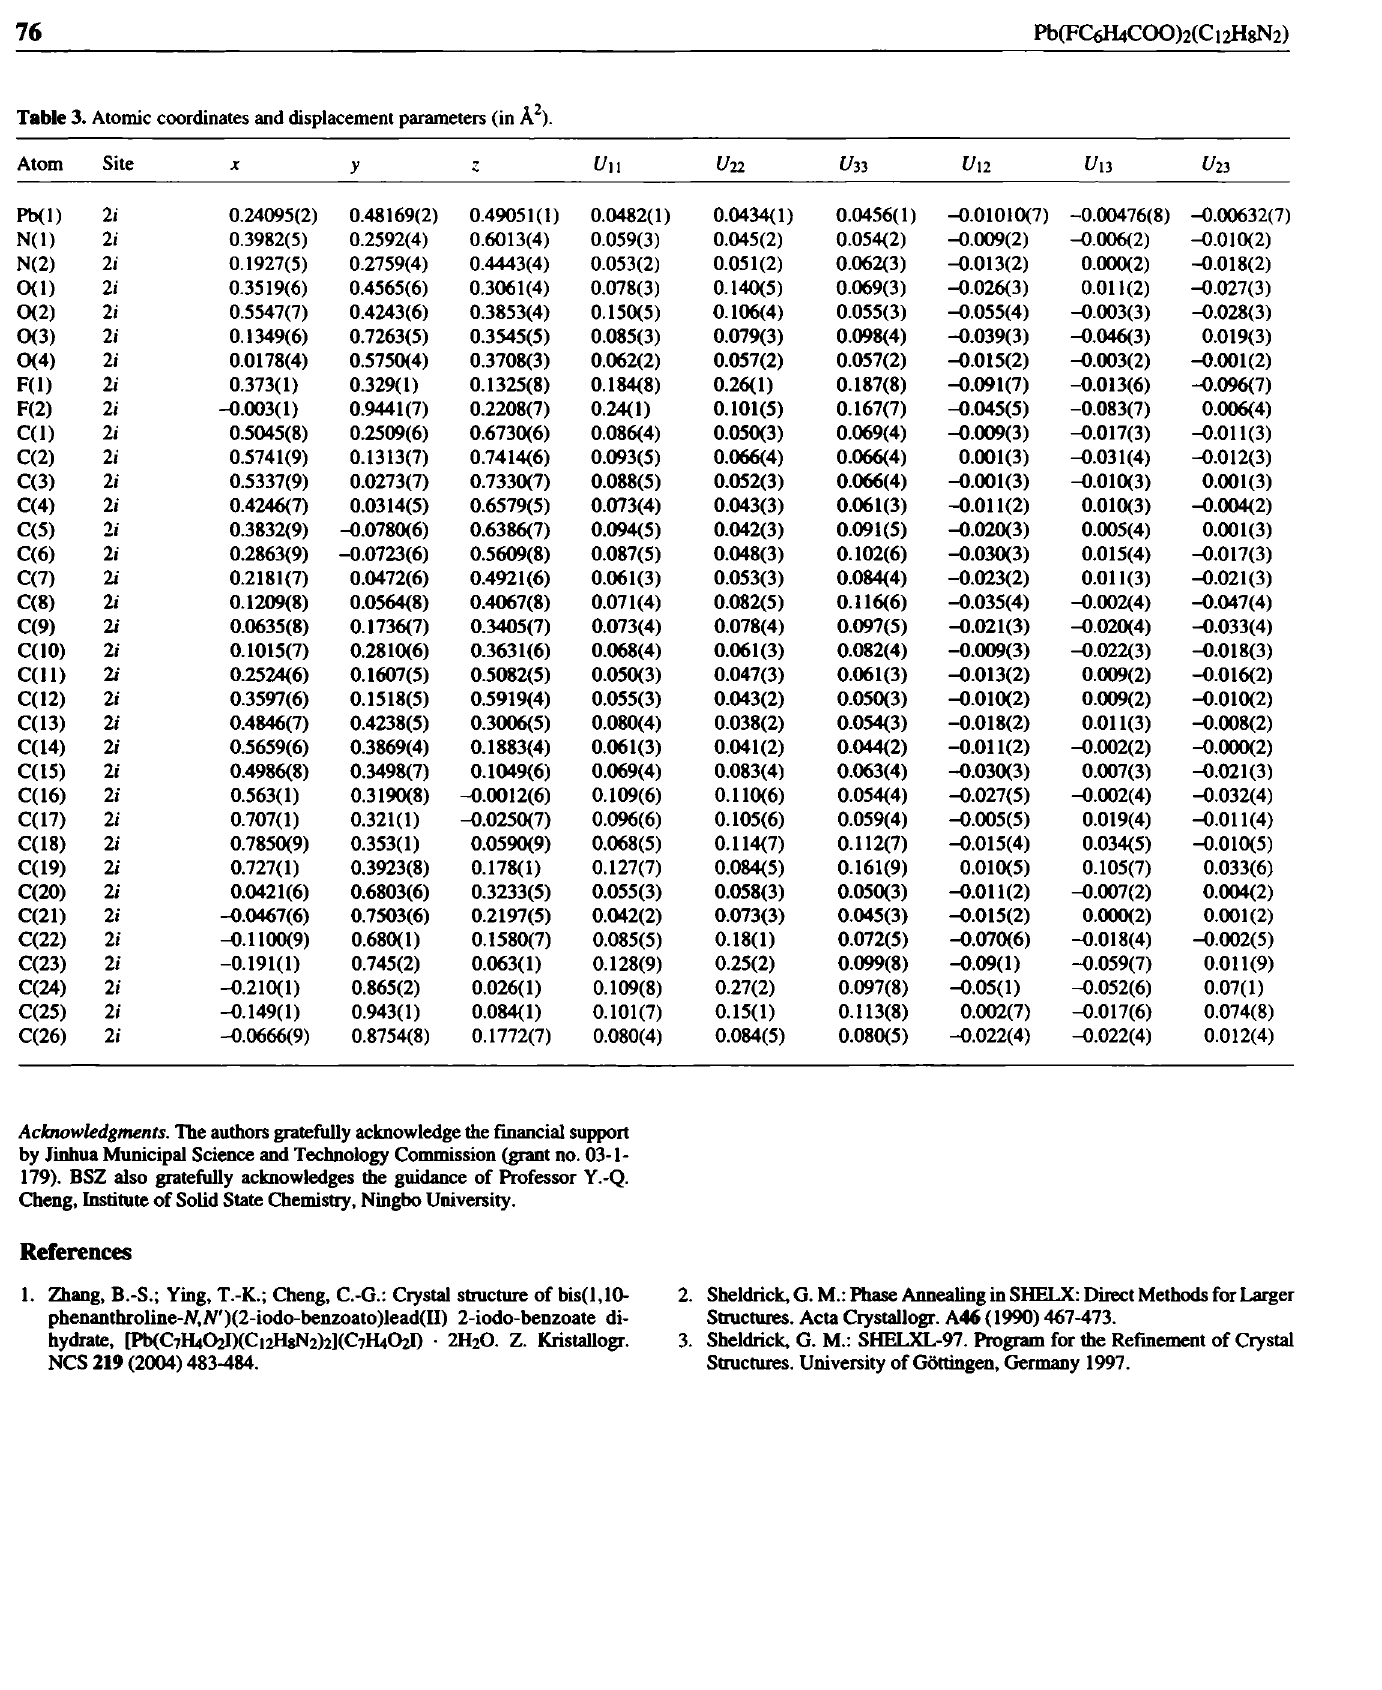
Table 3. Atomic coordinates and displacement parameters (in A 2